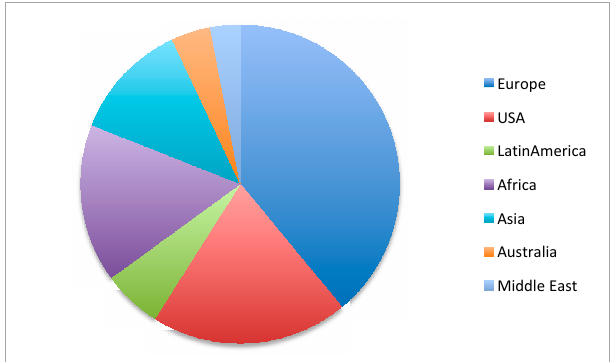
Figure 2. Countries of origin of the women whose voices are reported in the magazine (Source: authors’ elaboration).